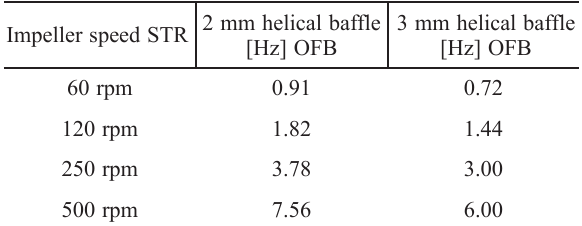
Fig. 1 – Oscillatory Flow Bioreactor (OFB) – lab plant schematic and a picture Table 1 – Impeller speed setting of STR and corresponding frequency setting of